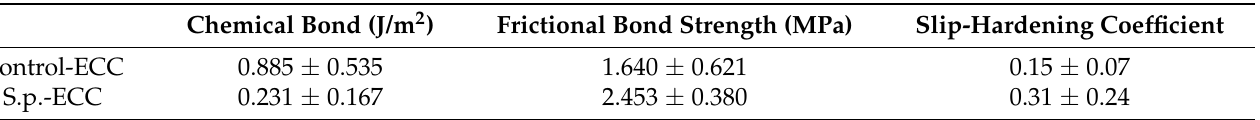
Figure 18. PVA surface comparison under SEM observation. ( a ) control-ECC. ( b ) S.p.-ECC. Table 7. Comparison of mean values of interface parameters for single fiber pullout